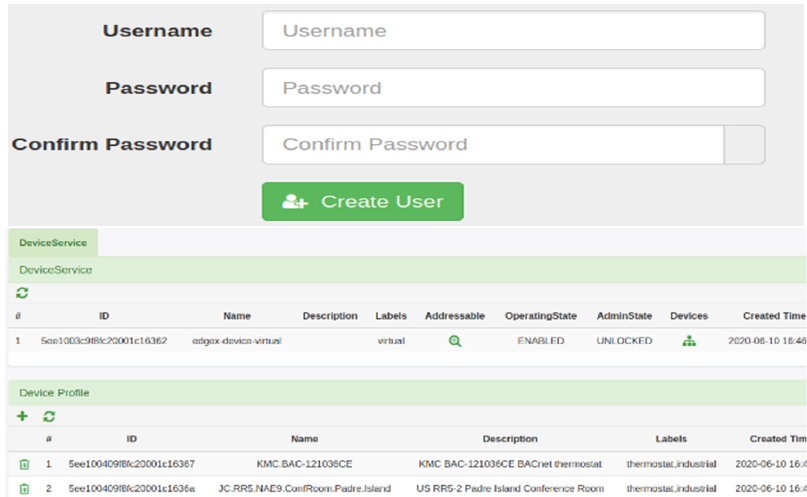
Figure 7. EdgeX usercreater UI and registered devices.